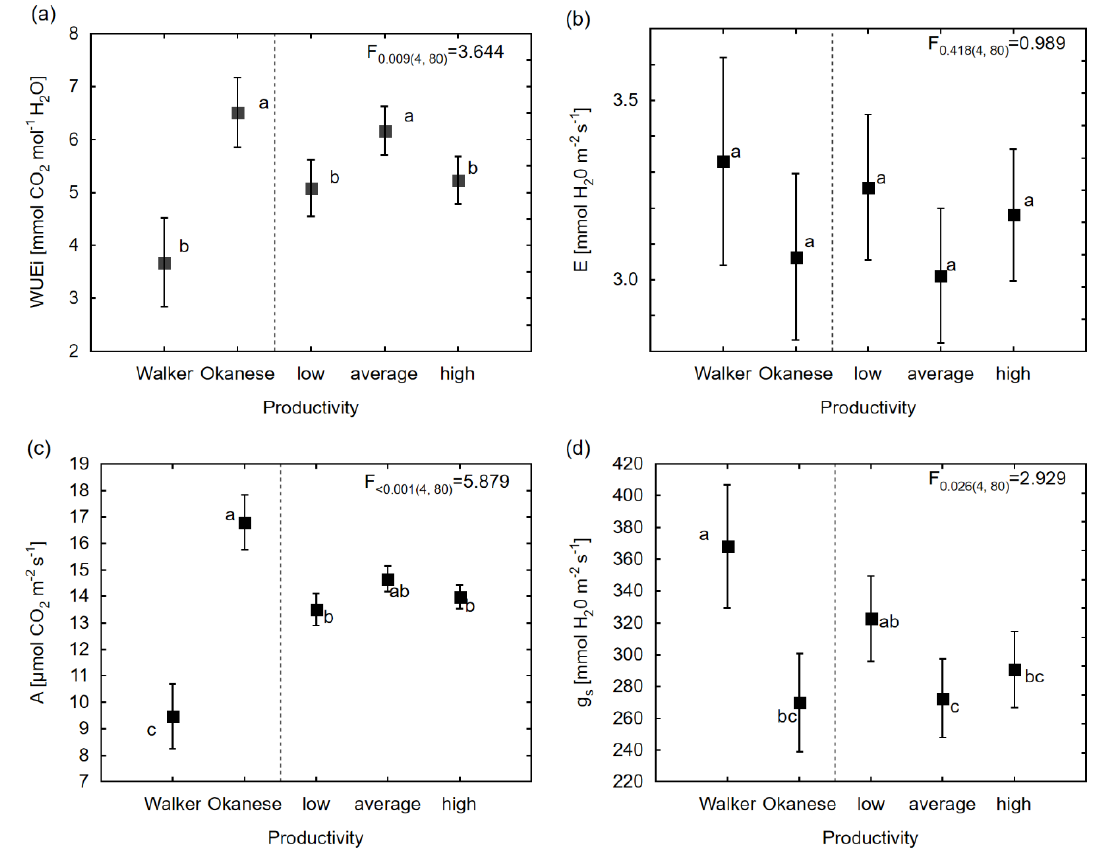
Figure 2. Estimated means for physiological traits in the linear mixed model and results of the least significant di ff erence (LSD) test for: ( a ) WUEi; ( b ) E; ( c ) A; ( d ) g s . The same letters signify homogeneous groups ( α = 0.05) in the post-hoc LSD test. The F-test values for productivity groups are shown with their p -values, followed by the degrees of freedom in brackets. The meaning of the trait abbreviations as in the Table 2 footnote.